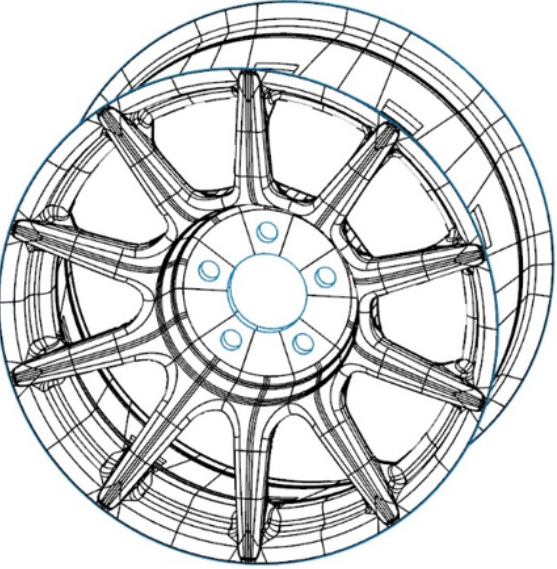
Figure 5: Surface model used for composite FE